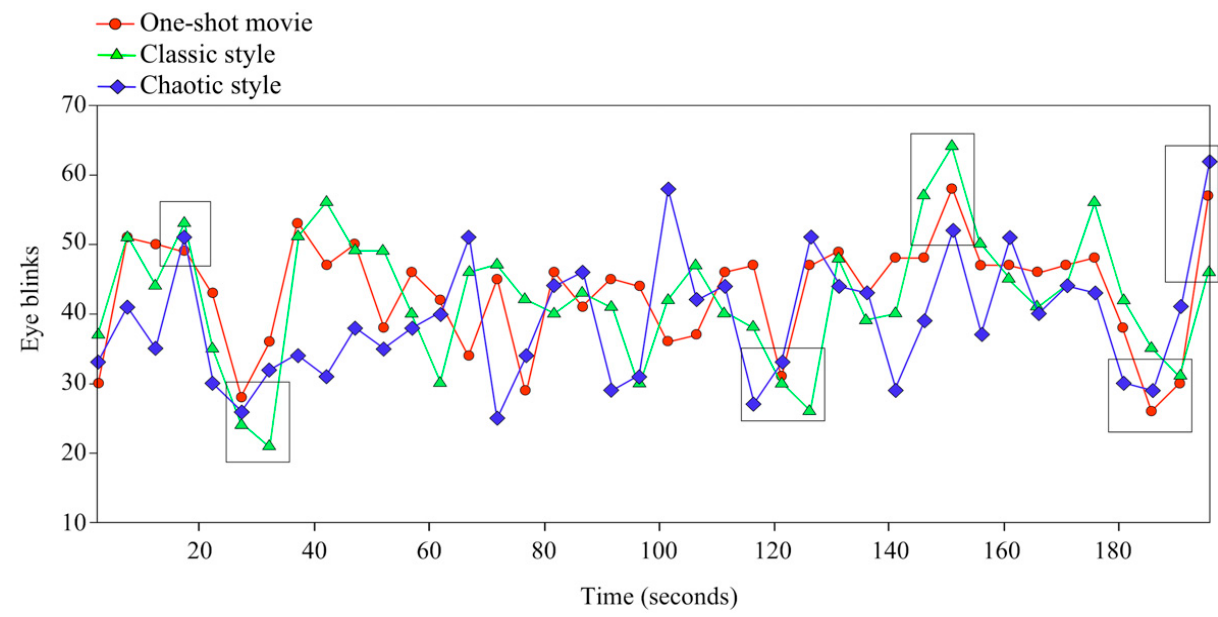
Figure 1. Timeline of the video, showing histograms of eye blinks from all participants ( N = 40) while watching the movie with each style. Red circles indicate blinks during the one-shot movie; green triangles those during the continuous movie, edited with a classical style; and blue squares those during the movie with discontinuous and chaotic style. The distribution is into 40 bins of 4.95 s each. The boxes indicate the moments and actions when viewers’ eye blinks coincide among the different styles of